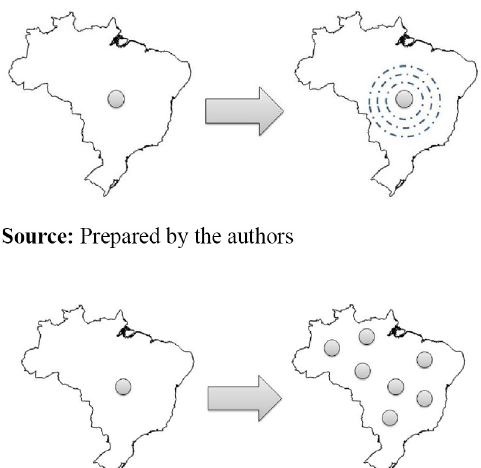
Figure 2. Representation of scaling